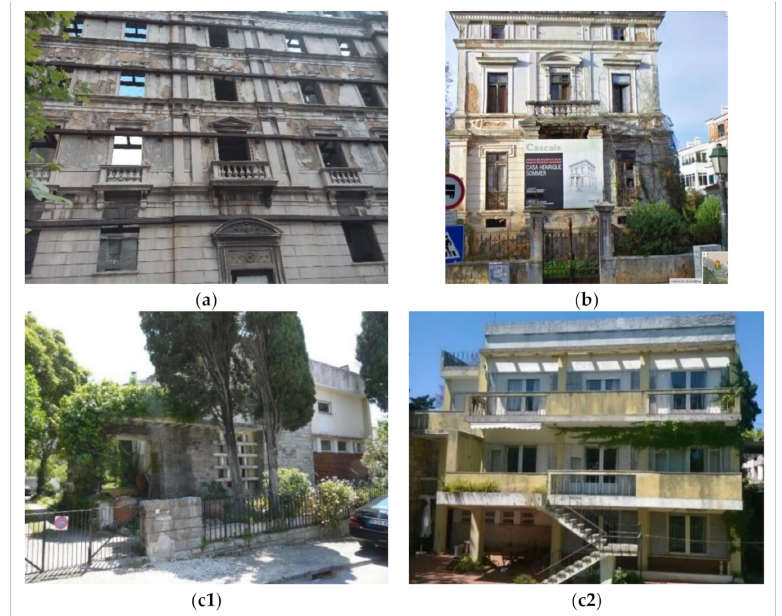
Figure 3. Facades in which it was necessary to maintain the external appearance, before retrofit: ( a ) case A; ( b ) case B; and ( c1 , c2 ) case